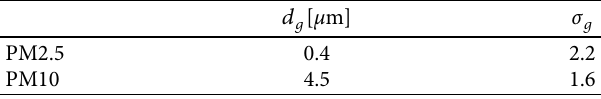
Table 3: Typical geometric mass mean diameter d geometric standard deviation σ g for PM2.5 and